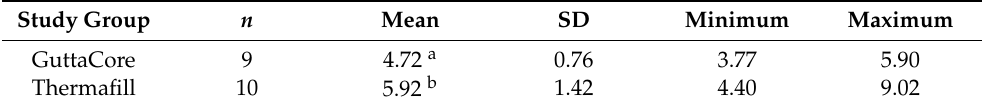
Table 5. Descriptive analysis of the time (min) used to remove the root canal filling materials inside the root canal